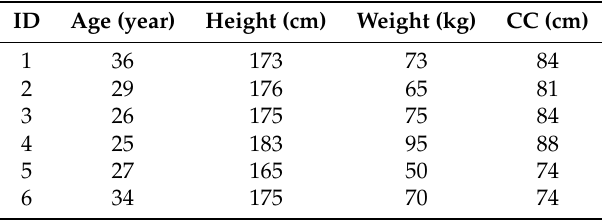
Table 3. Summary of subjects’ specifications. CC is the chest